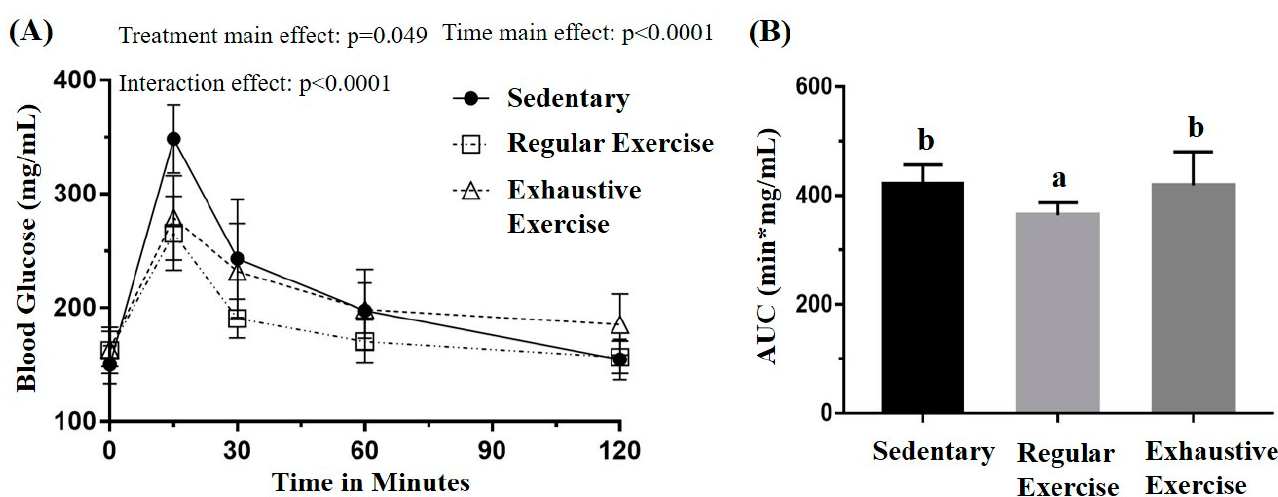
Figure 4. Effects of the eight-week training intervention on glucose tolerance ( A ) and area under the curve (AUC) ( B ). The oral glucose tolerance test was performed at the end of the study, and blood samples were collected at 0, 15, 60, 90, and 120 min after the oral dose of 1 g/kg glucose. Data are represented as mean ± standard deviation, and the columns with different letters (a, b) are significantly different between groups ( p < 0.05) by using one-way ANOVA.